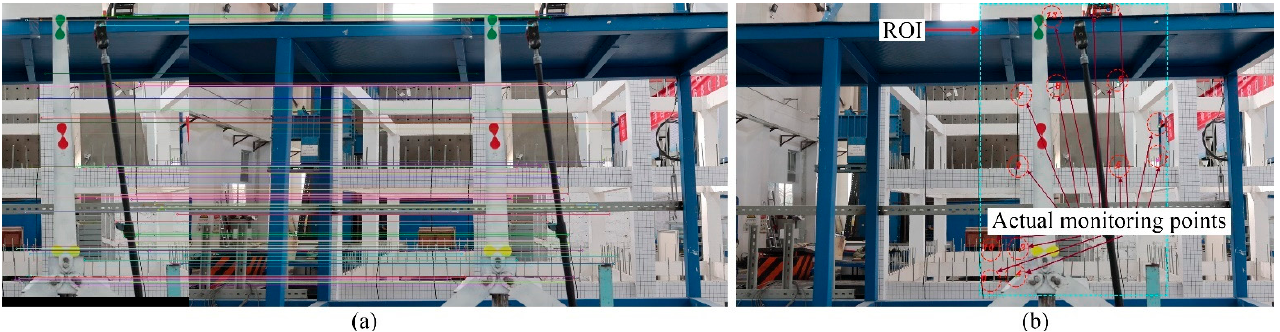
Figure 16. Monitoring effect of optical flow method in a complex background situation: ( a ) Harris corner matching in ROI area; ( b ) actual monitoring effect of optical flow method in ROI area.